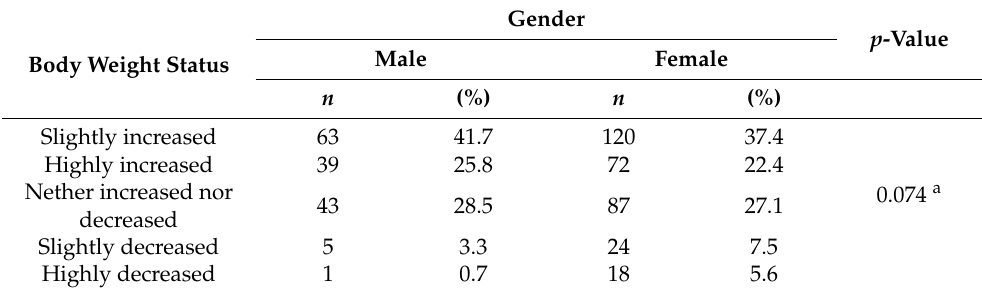
Table 3. Comparison of the body weight status and gender during the full COVID-19 curfew